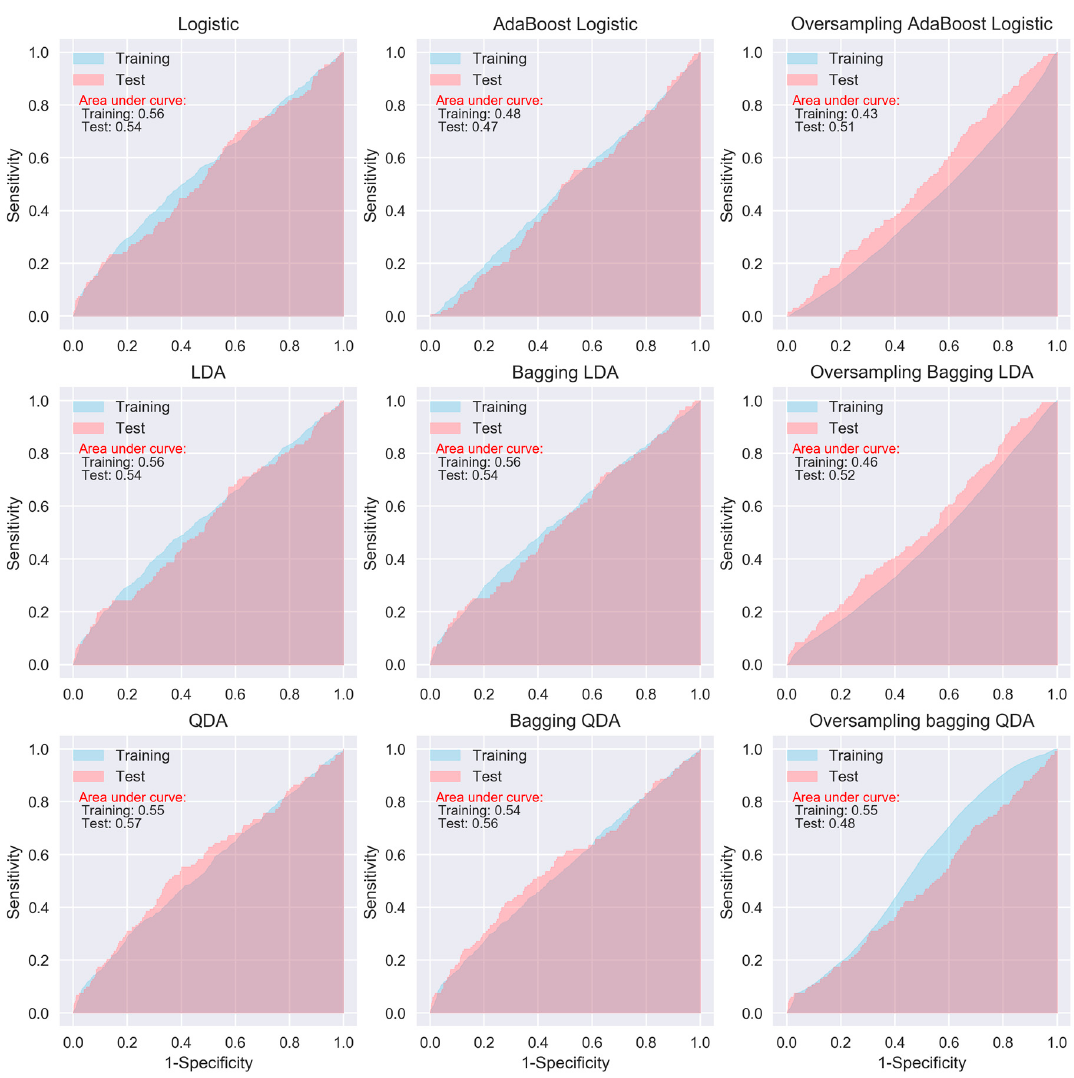
Figure 2. Receiver operating characteristic (ROC) curves of logistic regression, LDA, and QDA.